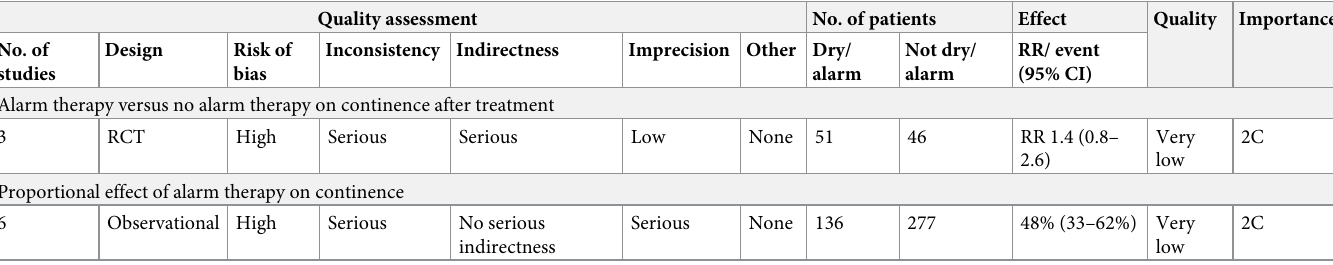
Table 2. Assessment of evidence according to